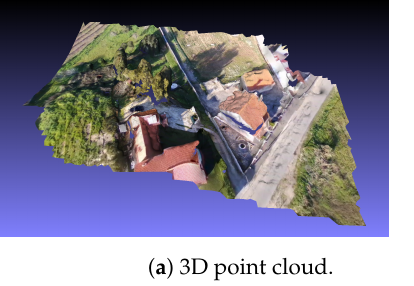
Figure 26. Point cloud models obtained from RGB images.